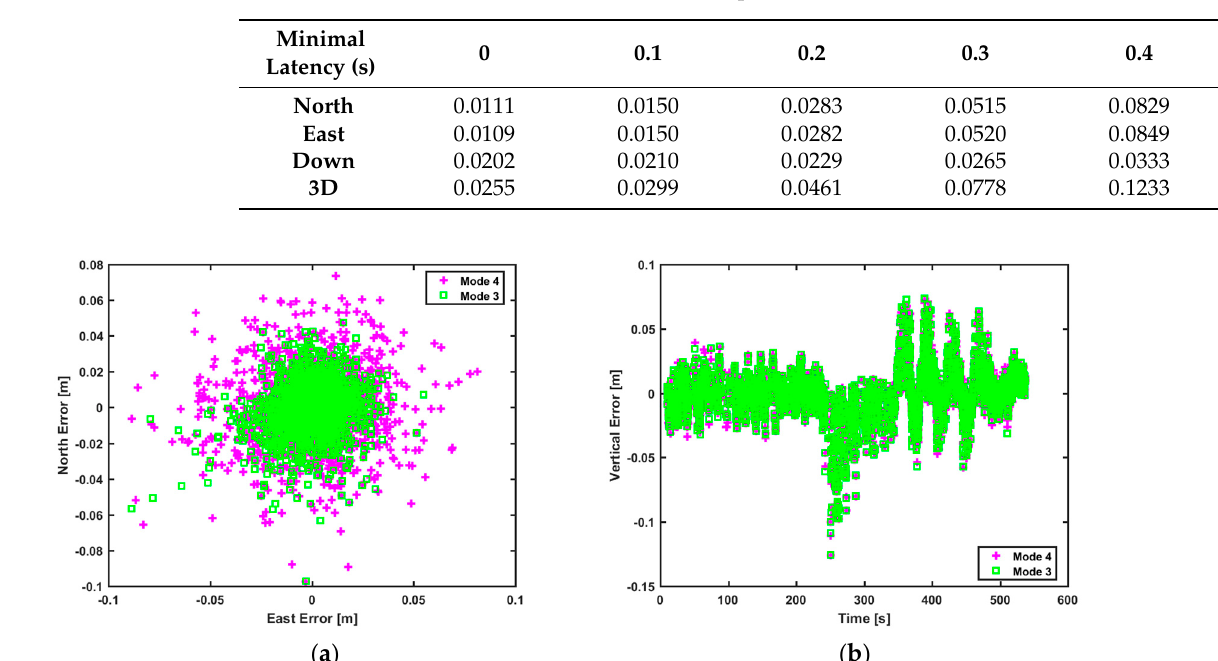
Figure 19. Error scatterplots of modes 3 and 4 in test 1. ( a ) Horizontal direction; ( b ) vertical direction. Compared with 10-Hz output of sole RTK DGNSS relative positioning, modes 2, 3 and 4 can provide 125-Hz, centimeter-level-accuracy relative positions with data broadcast rates reduced by 76.24%, 76.24% and 83.12%, respectively. Additionally, the sampling rate can also be reduced from 10 Hz to 1 Hz in modes 3 and